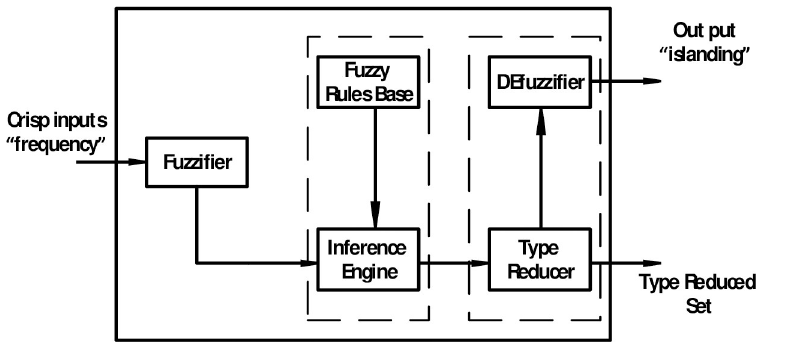
Fig 3. Schematic of the